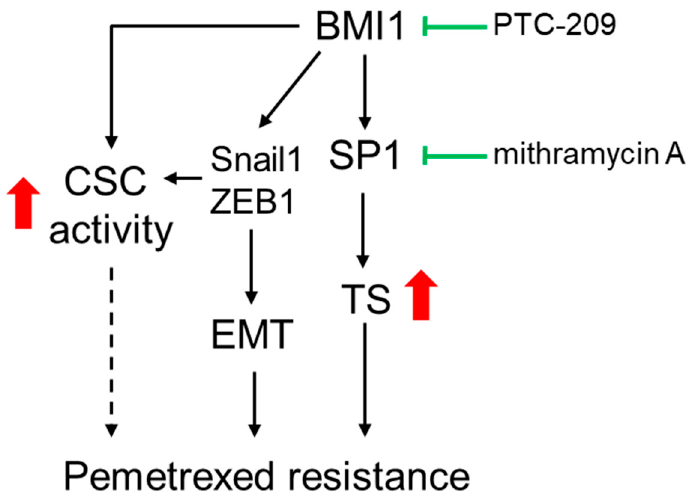
Figure 8. The proposed model for BMI1 involved pemetrexted resistance in NSCLC. The role of BMI1 in pemetrexed resistance could result from three ways including (1) the upregulation of SP1 followed by increased TS expression; (2) The enhancement of the EMT process by upregulating Snail1 or ZEB1 expression; (3) The elevation of CSC activity. Inhibition of BMI1 or SP1 activity by PTC-209 or